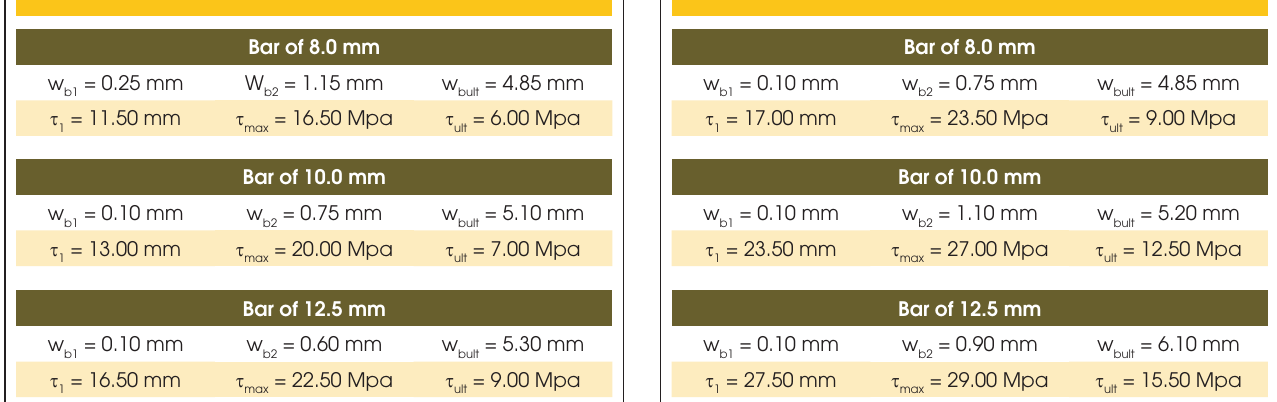
Table 6 – Parameters for the Hawkins bond law for concrete C25